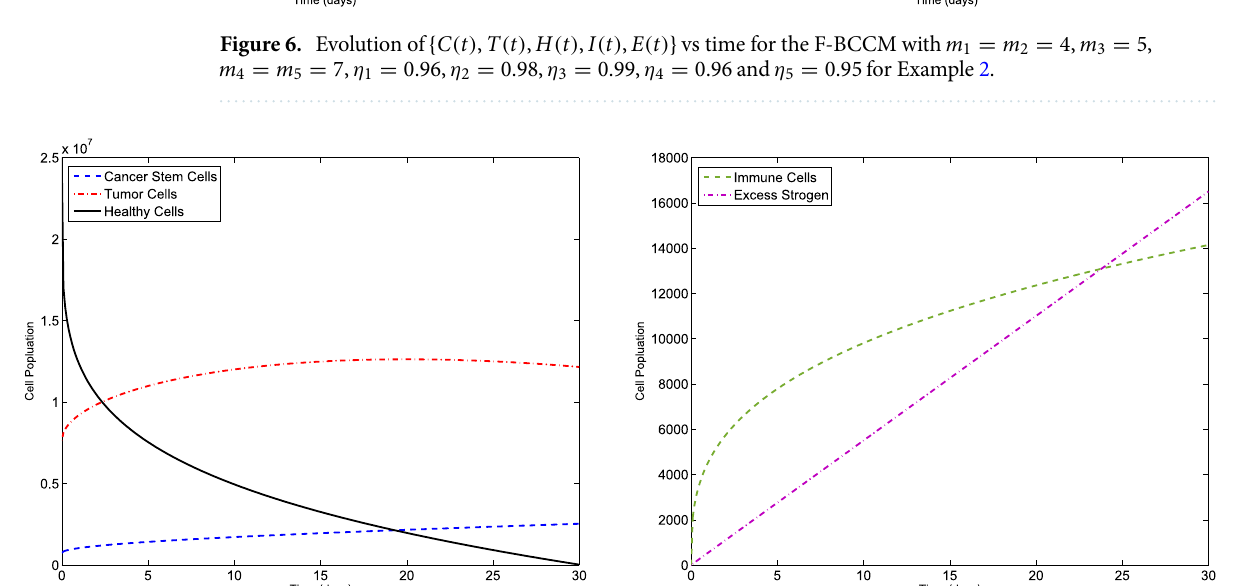
Figure 7. Evolution of { C ( t ) , T ( t ) , H ( t ) , I ( t ) , E ( t ) } vs time for the F-BCCM with m 1 = m 2 = m 3 = 6